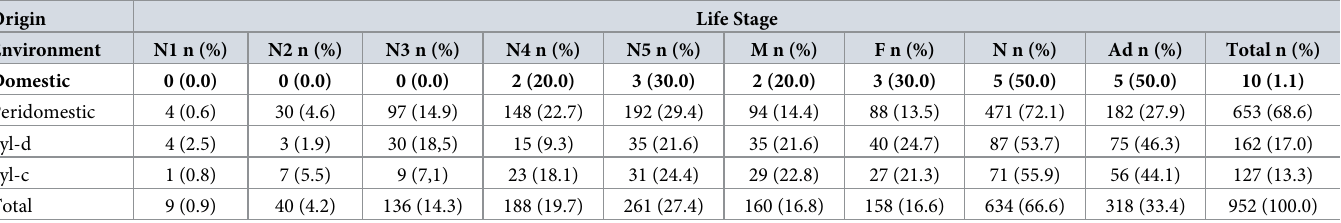
Table 2. Environment infestation and life stage of Triatoma b . brasiliensis captured in Pedregulho, Ina´cio, S ã o Bernardo de Elias, Riacho do Santo, and Batalh ã o de Engenharia de Construc¸ ã o localities in the Caico´ municipality, Rio Grande do Norte, Brazil. Origin Life Stage Environment